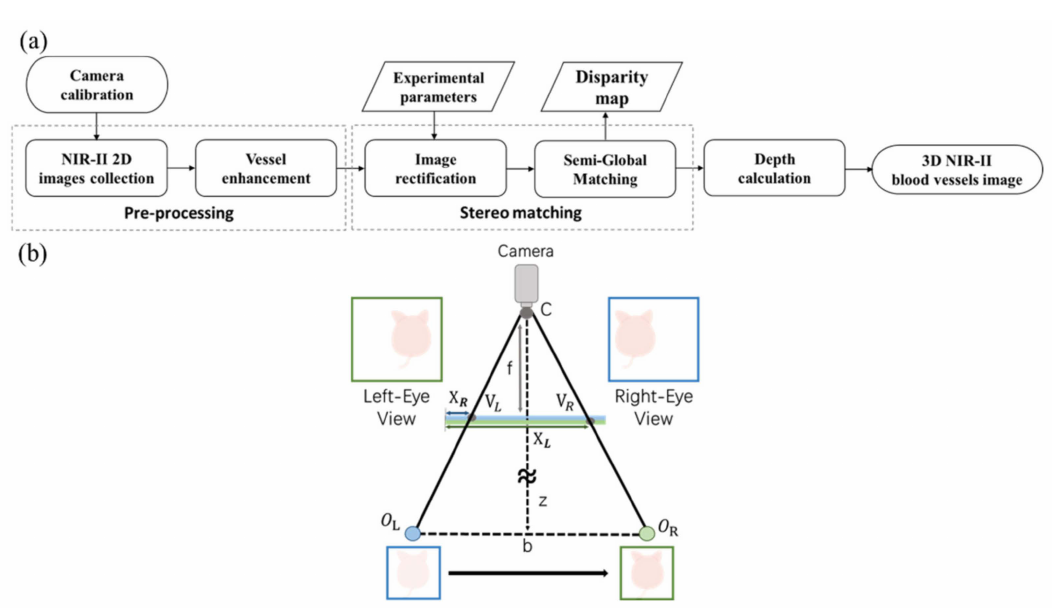
Figure 2. ( a ) The flow chart of the proposed NIR-II fluorescence stereo imaging system for 3D vascular imaging ( b ) Configuration scheme of our fluorescence stereo imaging